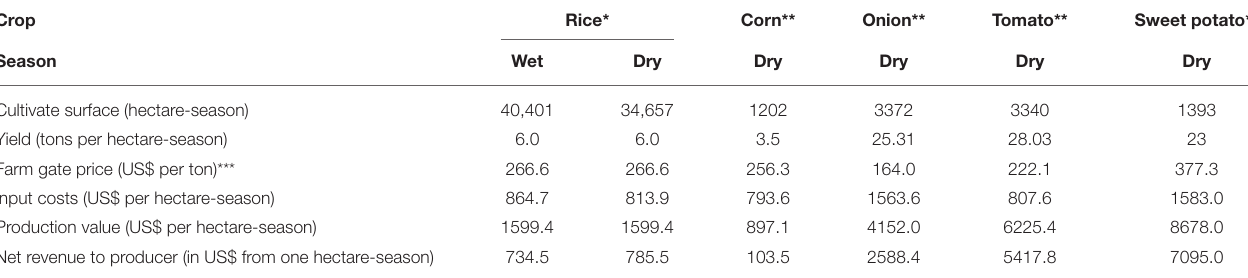
TABLE 1 | Revenues to growers from hectare in the irrigated scheme of the S-SRV corresponding to 2010. Crop Rice * Corn ** Onion ** Tomato